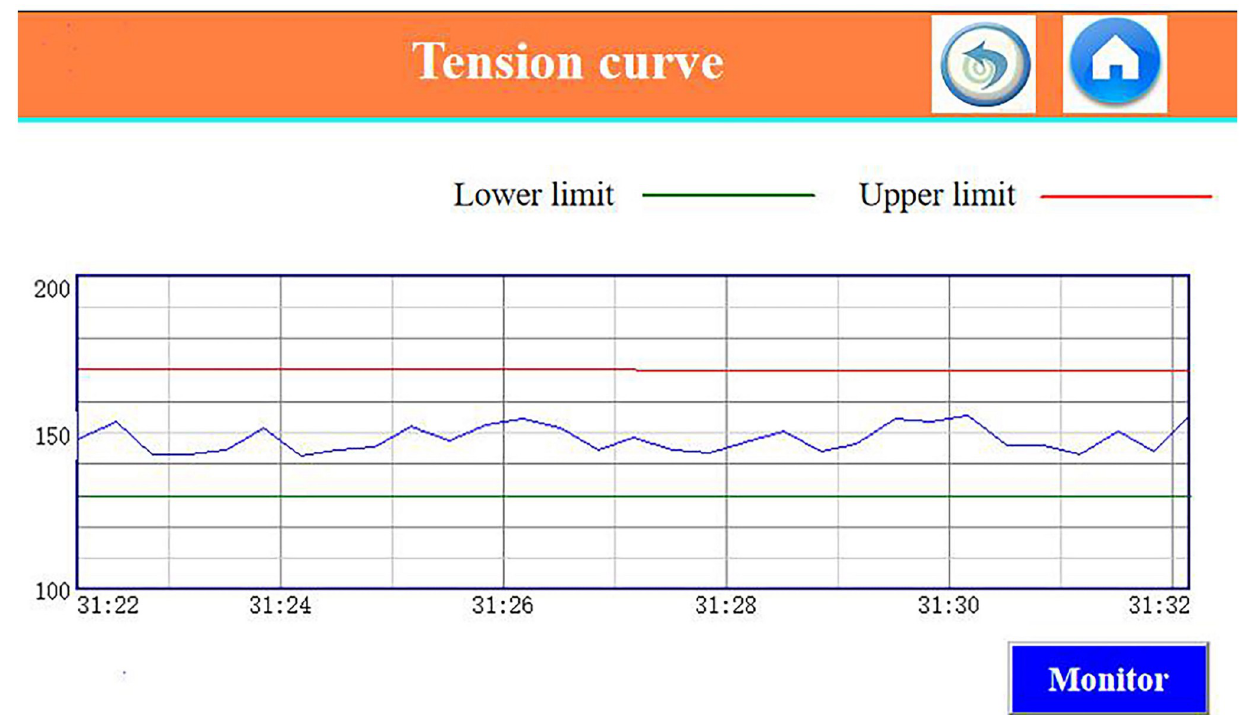
Fig 17. Tension test curve.